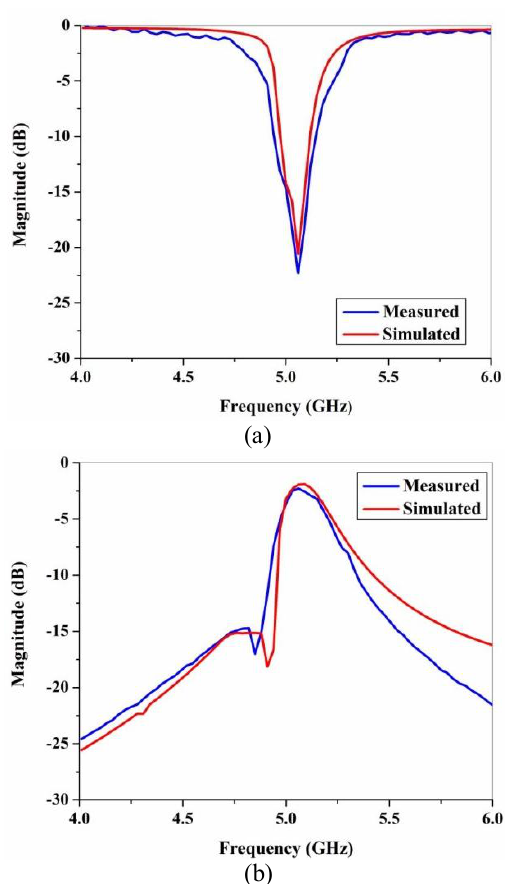
Figure 10: Simulated and measured results of bandpass filter using horizontal slot (Filter A) (a) return loss, (b) insertion loss.